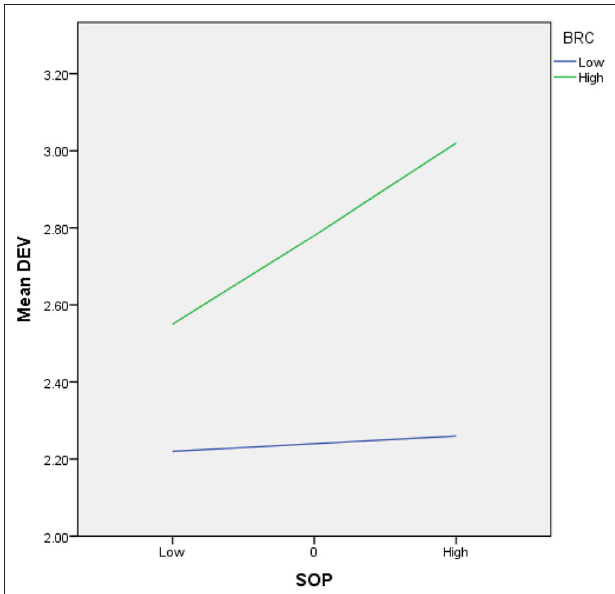
FIGURE 2 | Moderating effect of bureaucratic culture on the relationship between the sense of power and interpersonal